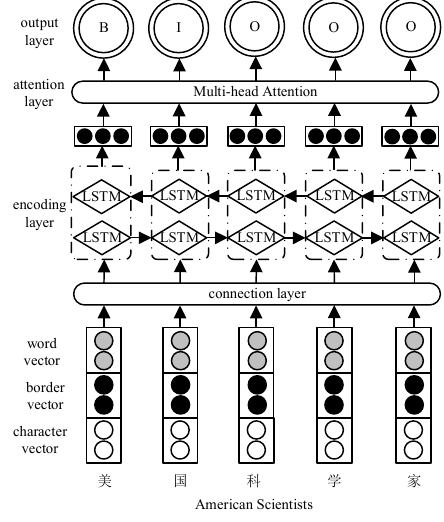
Figure 1. model framework. Figure 1. Model